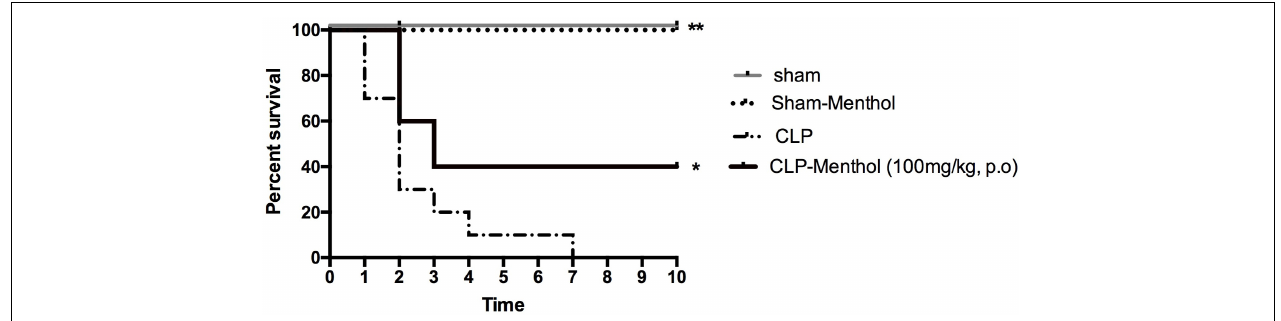
FIGURE 1 | Effect of Menthol treatment on sepsis-induced mortality. Surgical induction of sepsis by the cecal ligation and puncture (CLP) procedure resulted in 100% mortality within 7 days ( n = 10). Menthol treatment (100 mg/kg, p.o), 2 h after CLP, significantly improved the survival of septic rats ( n = 10). Sham or sham menthol-treated rats ( n = 10) showed no mortality. Survival analysis was carried out using the Log-rank Mantel-Cox test. * and ** Significantly different from the vehicle-treated CLP group at p < 0.05 and p < 0.01, respectively.